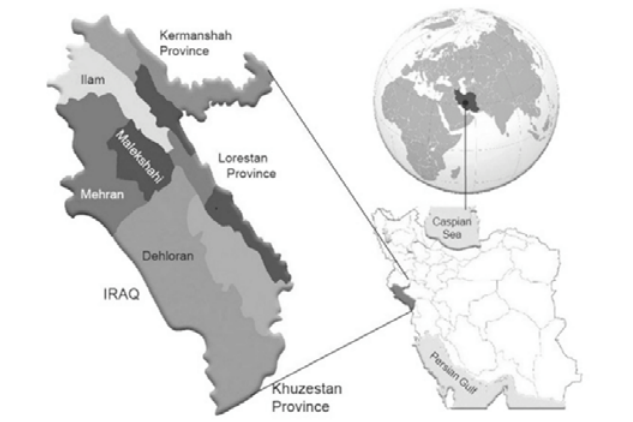
Figure 1. Location of contaminated and non-contaminated soil samples